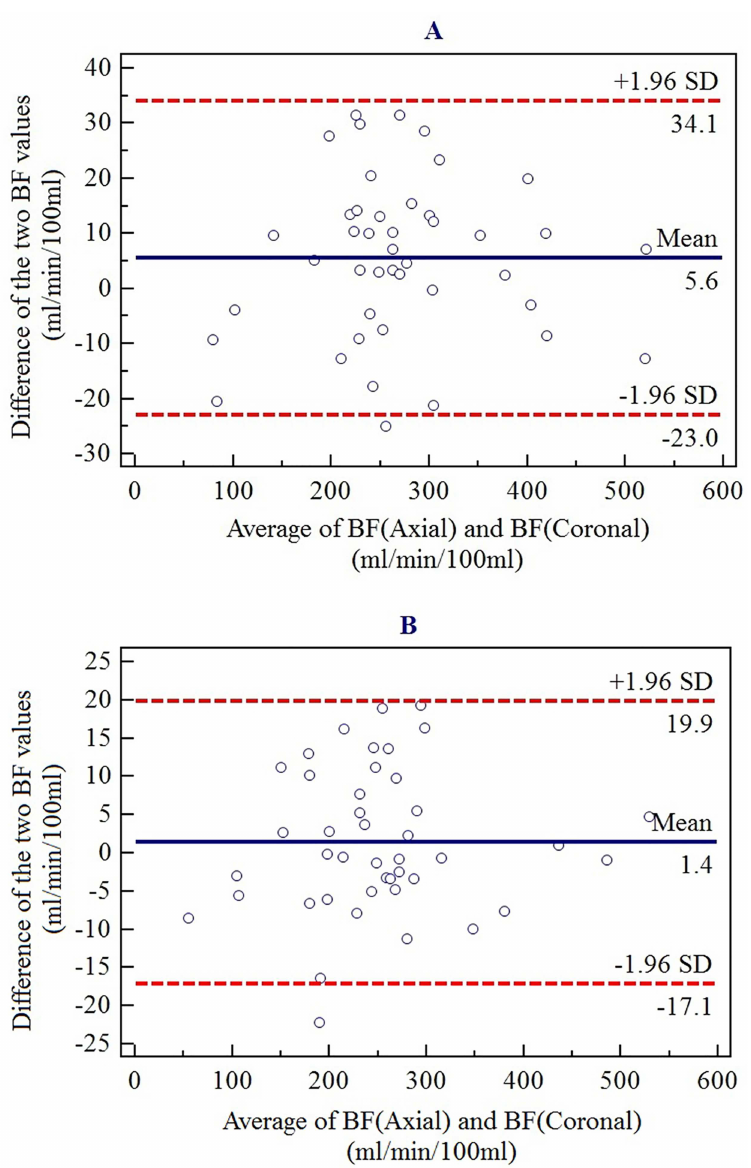
value differencesbetweenthe two planesfor left kidney. Mean difference (blue line), mean difference ± 1.96 SD (red